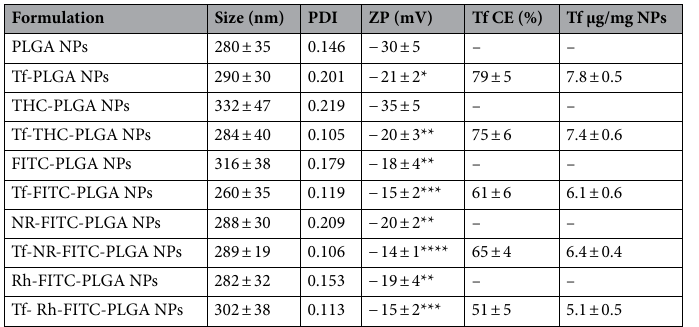
Table 1. Physicochemical properties of the formulations. Tf CE Tf conjugation efficacy. Statistically significant differences in ZP values are referred to plain PLGA NPs as control group; *p < 0.0332; **p < 0.0021; ***p < 0.0002; ****p <